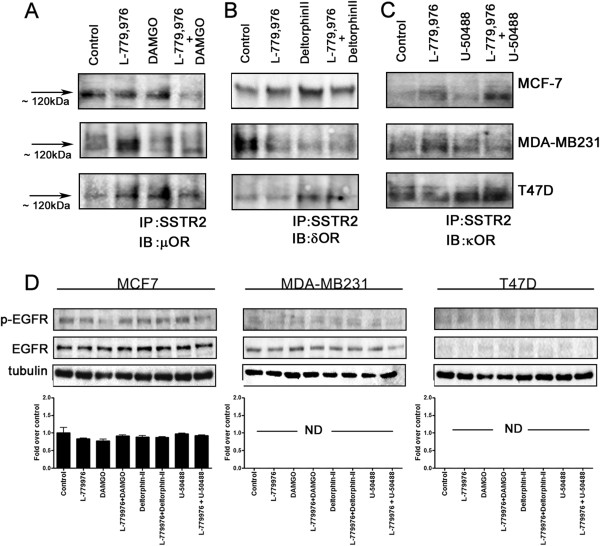
Agonist dependent complex formation between SSTR2/ORs and inhibition of EGFR phosphorylation. Co-immunoprecipitation showing the expression of μOR (A), δOR (B) and κOR (C) in SSTR2 immunoprecipitate obtained from MCF-7, MDA-MB231 and T47D cells following indicated treatment. The agonist-induced heterodimerization between SSTR2 and μOR, δOR or κOR is receptor and cell-specific. (D) Western blot showing SSTR2 and ORs mediated inhibition of EGFR phosphorylation in breast cancer cells. MCF-7 cells displayed EGFR phosphorylation comparable to control without any discernible difference upon indicated treatment. Note the lack of EGFR phosphorylation in MDA-MB231 despite basal EGFR expression whereas T47D cells were devoid of EFGR expression and phosphorylation. Tubulin was used as a loading control.